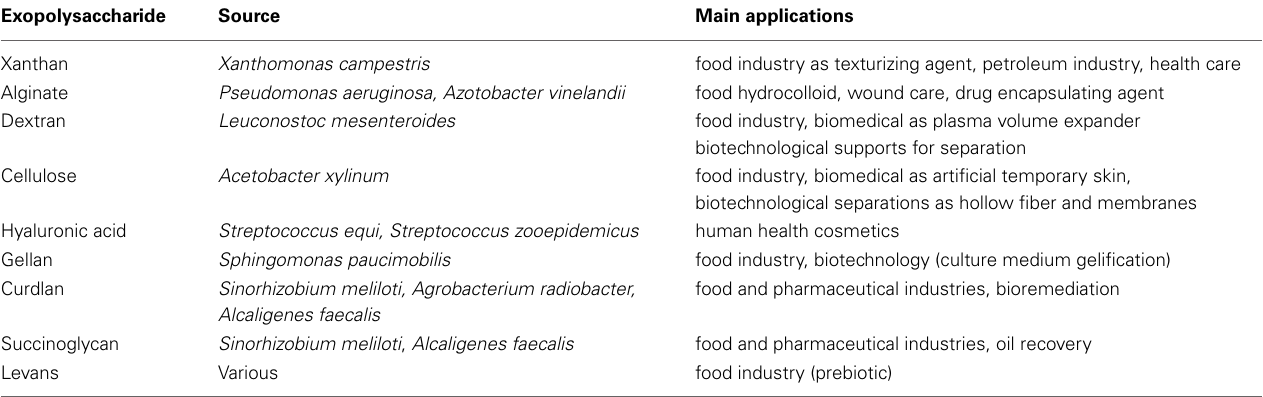
Table 1 | Examples of microbial used macromolecules (adapted from Kumar et al., 2007; Freitas et al.,